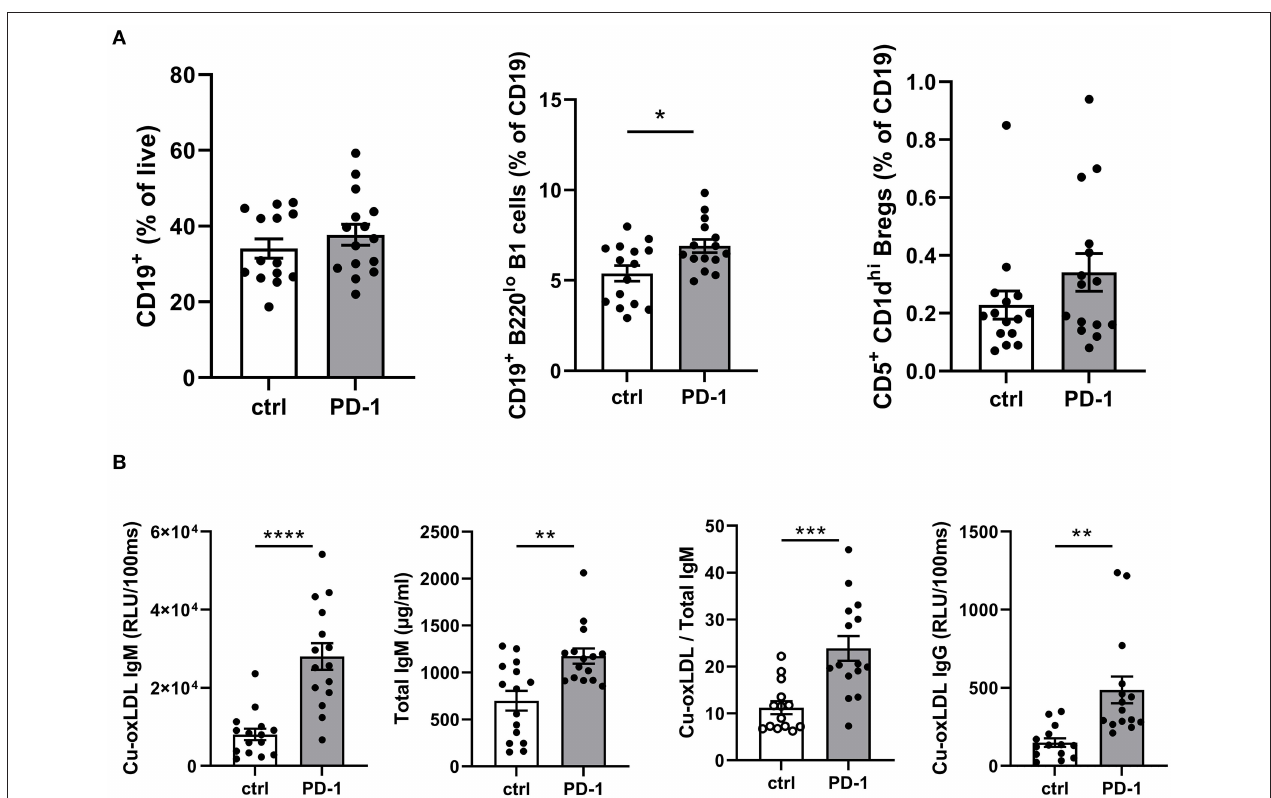
FIGURE 4 | Elevated B1 cells and oxLDL-IgM levels in agonistic PD-1 treated mice. Total CD19 + B cells, B1 cells (CD19 + B220 lo ) and regulatory B cells (CD19 + CD5 + CD1d hi ) were measured by flow cytometry in blood (A) . Serum Cu-oxLDL IgM (relative light units (RLU)/100 ms), total IgM ( µ g/ml), Cu-oxLDL IgM/total IgM ratio, and Cu-oxLDL IgG (RLU/100ms) were measured by ELISA (B) . Mean ± SEM are shown. Statistics was performed using unpaired T -test. P ≤ 0.05 are considered significant. * p ≤ 0.05, ** p ≤ 0.01, *** p ≤ 0.001, **** p ≤ 0.0001.